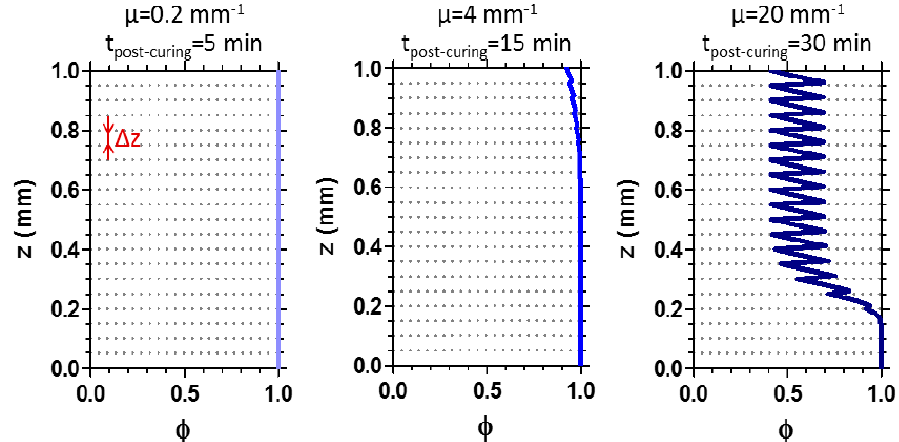
Figure 8. Conversion φ profiles along the sample depth z for 3D printed objects after post-curing. The layer thickness during the printing process ( Δ z ) is set as 50 μ m. Profiles are modeled imposing μ = 0.2 mm − 1 , μ = 4 mm − 1 and μ = 20 mm − 1 , I = 3 W·m − 2 , and the post-curing time as 5 min, 15 min and 30 min, respectively.